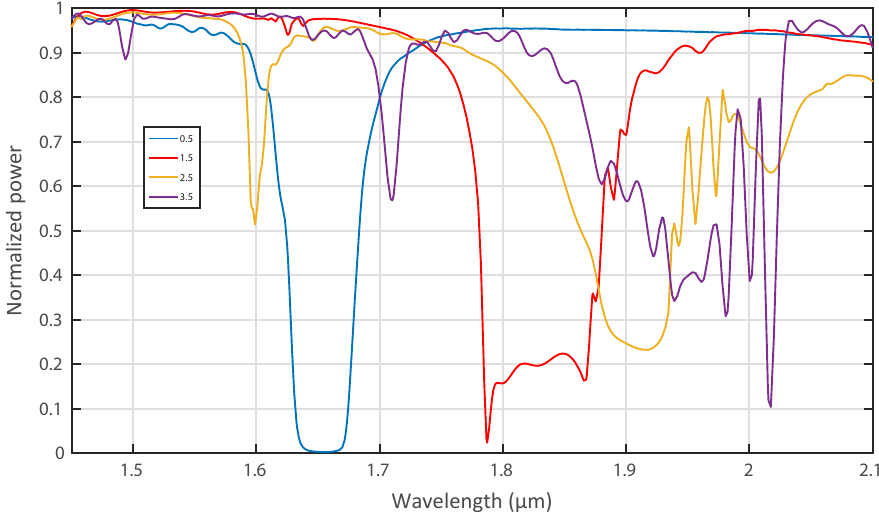
Figure 2. The transmission spectra of the triangular lattice waveguides with different column numbers of air